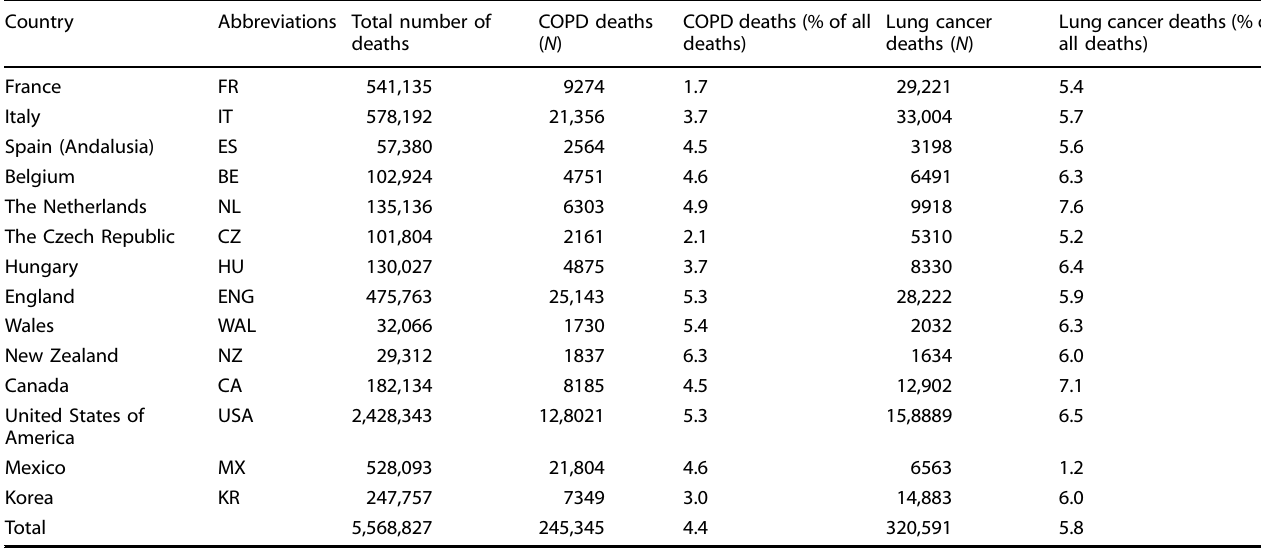
Table 1. Deaths from COPD and lung cancer in 14 countries during the year 2008 ( N = 5,568,827)